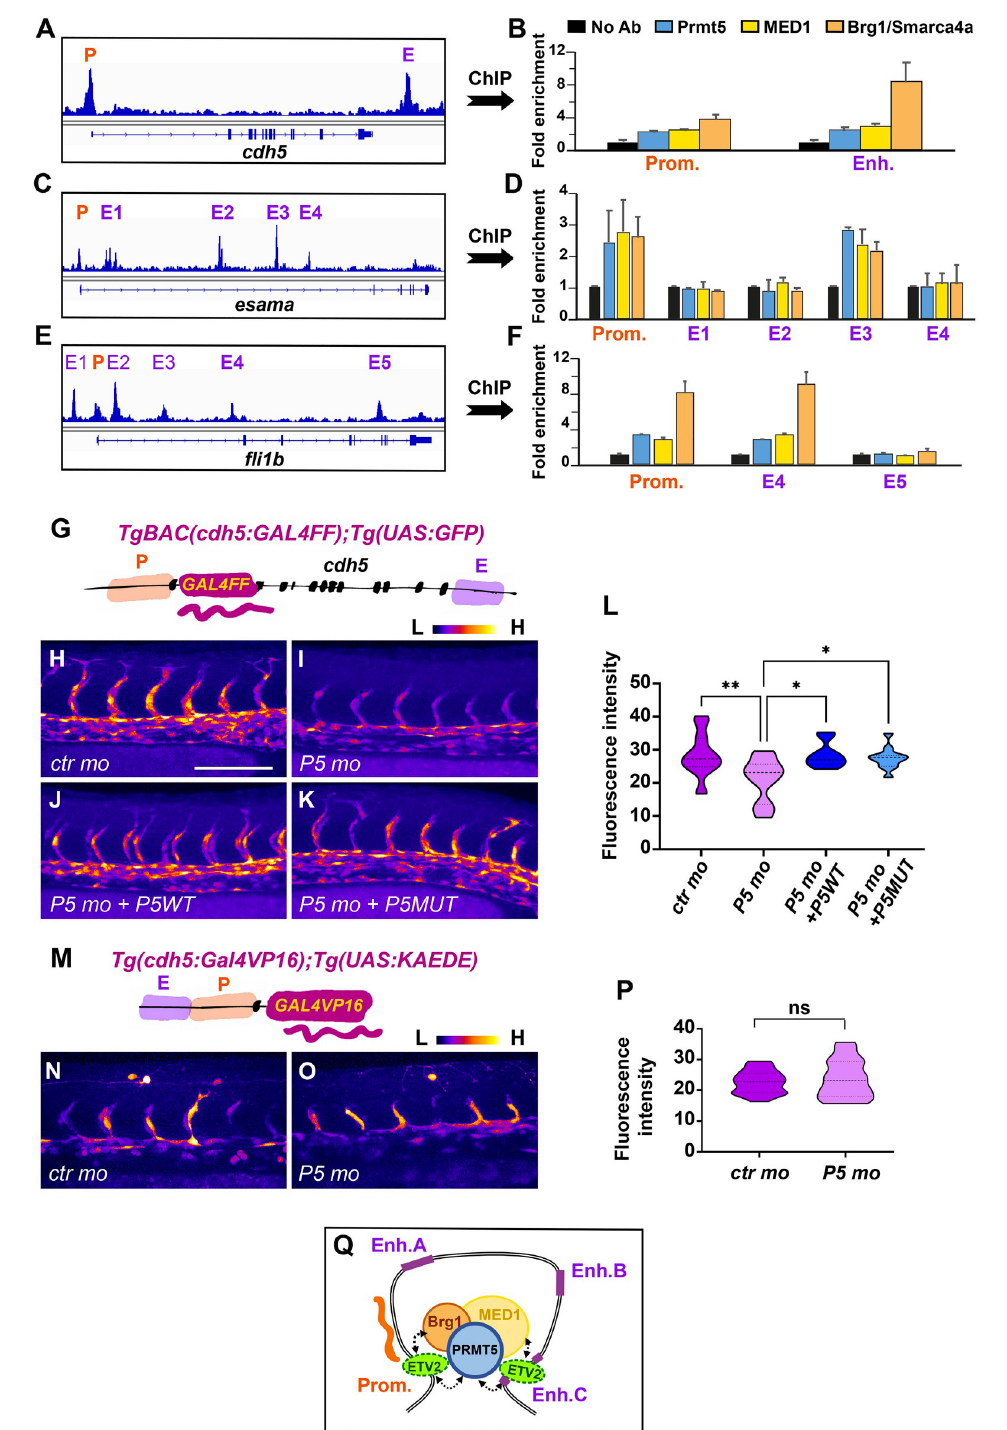
Fig 5. Prmt5 promotes chromatin looping. (A-F) ChIP experiments with the indicated antibodies on cdh5 (A, B), esama (C, D) and Fli1b (E, F) regulatory sequences. P, promoter; E, enhancer. Samples were analyzed in duplicates from 2 experiments. Fold enrichment was calculated relative to the input and to a negative region on the genome and then relative to the mock ChIP (No antibody). (G) Schematic representation of the transgene TgBAC(cdh5 : GAL4FF) containing two putative cis- regulatory elements, a promoter region (P) and an enhancer (E), separated by ~20kb with the GAL4FF reporter gene